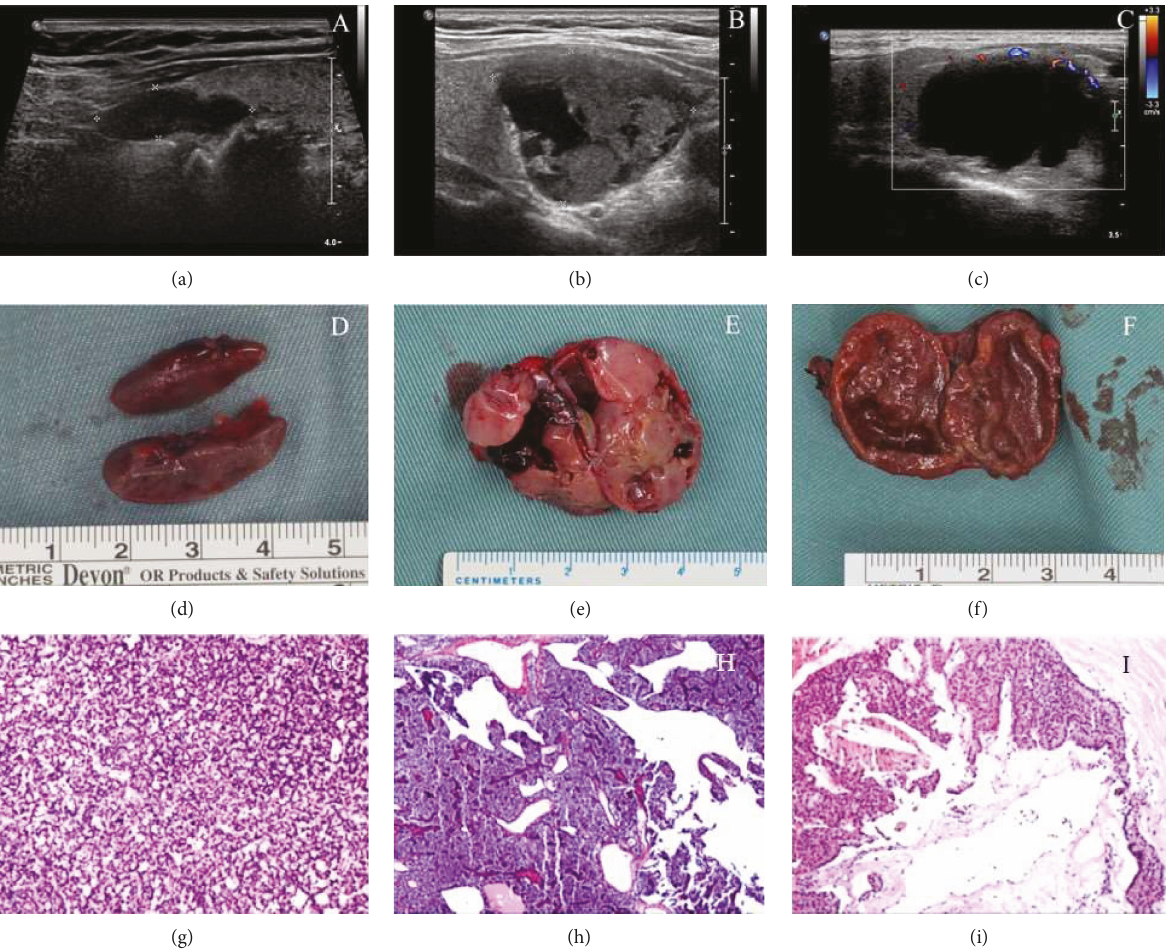
Figure 1: Sagittal ultrasound images (a, b, c), photographs (d, e, f), and histological features (hematoxylin/eosin staining) (g, h, i) of representative parathyroid adenomas. (a, d, g) Solid parathyroid adenoma without any cystic component. (b, e, h) Solid parathyroid adenoma with an insigni fi cant cystic component. (c, f, i) Cystic parathyroid